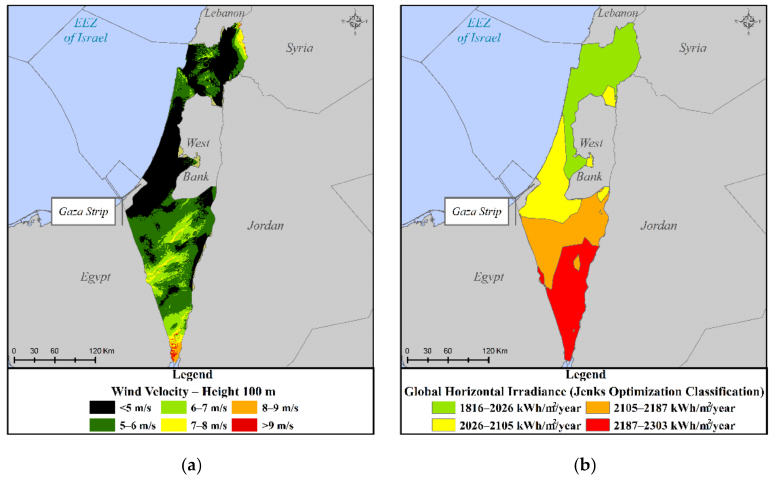
Figure 5. Thematic maps of ( a ) Wind Velocity (WSC.1) and ( b ) Global Horizontal Irradiance (GHI) (SSC.1) as defined in Table